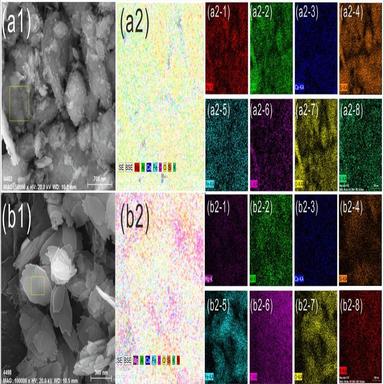
The elemental distribution map of various elements performed on the surface of AT (a) and AT-NS (b).